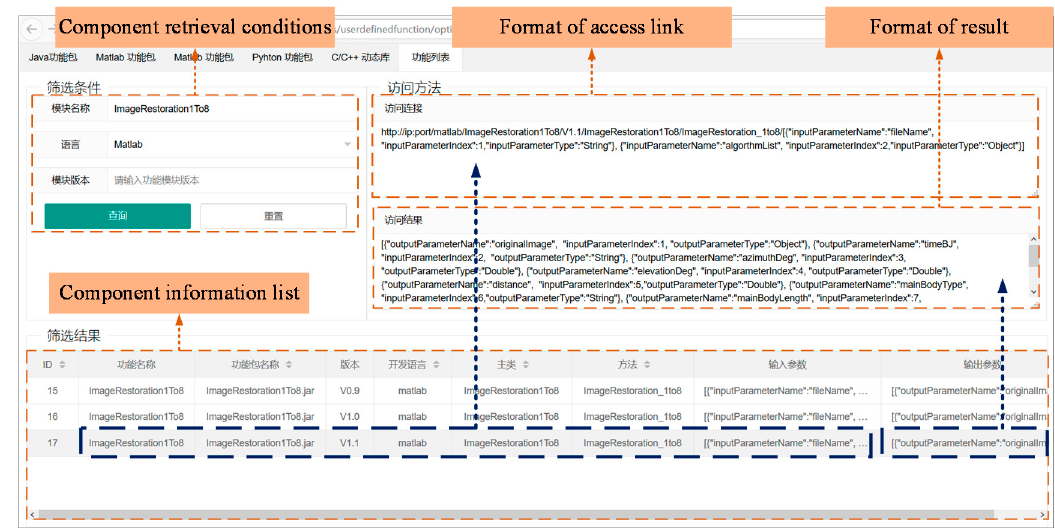
Figure 1. Module list and information retrieval. The format of the access link and the processing result of the selected algorithm can be obtained.